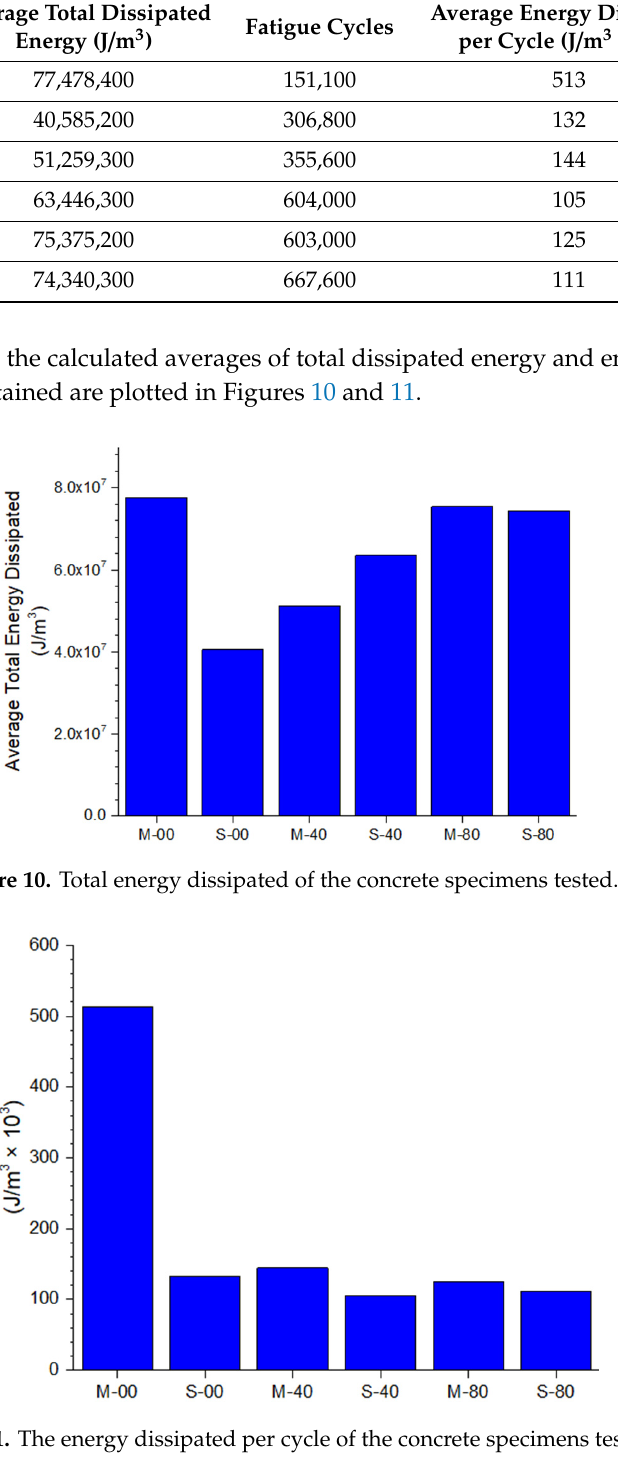
Table 7. Averages of total dissipated energy and dissipated energy per cycle from fatigue tests.